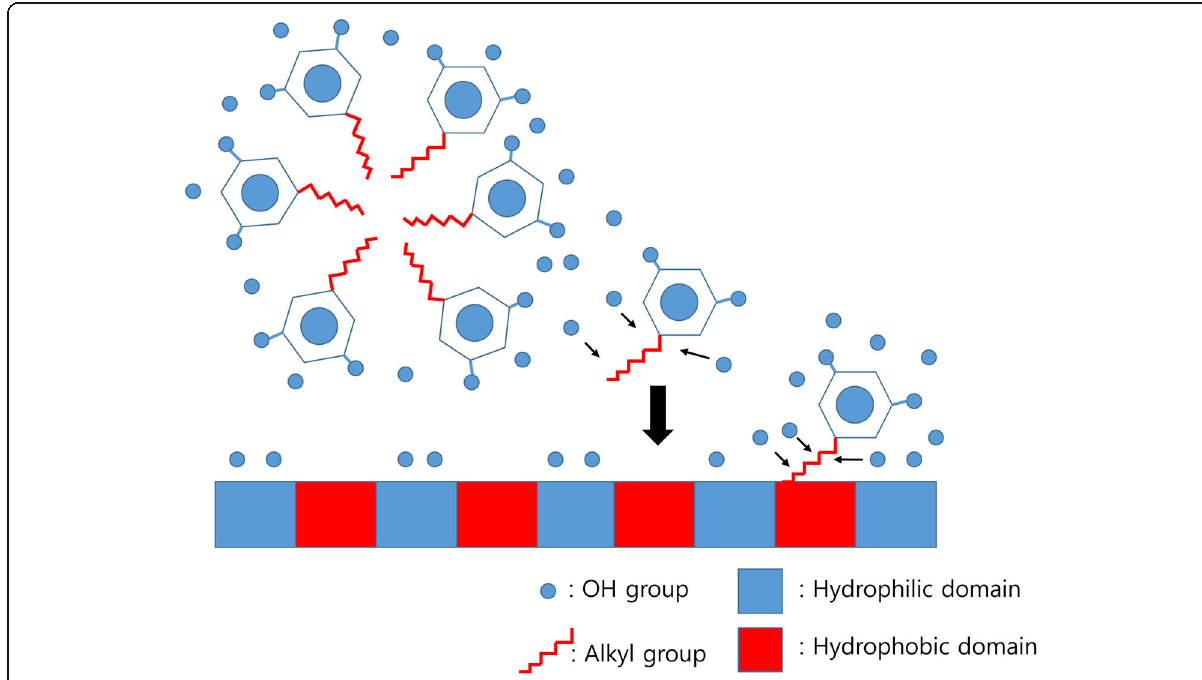
Fig. 6 Smart delivery of 4-hexylresorcinol (4HR) using hydrophobic and hydrophilic domains of silk fibroin. Silk fibroin is a macromolecule composed of hydrophilic and hydrophobic domains. As 4HR is composed of a long alkyl group (hydrophobic) and 2 hydroxyl groups (hydrophilic), 4HR can be bound to each domain according to its molecular interaction. As hydrophilic interactions are much weaker than hydrophobic interactions, 4HR in the hydrophilic domain of silk fibroin is released first. 4HR in the hydrophobic domain is released during